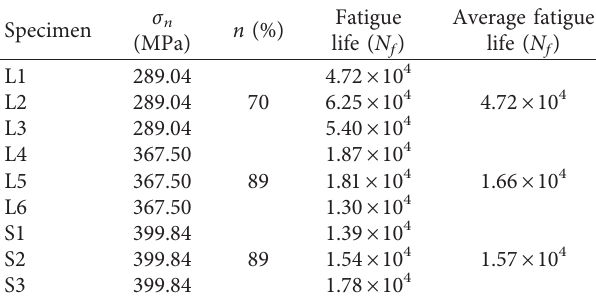
fatigue test to tensile